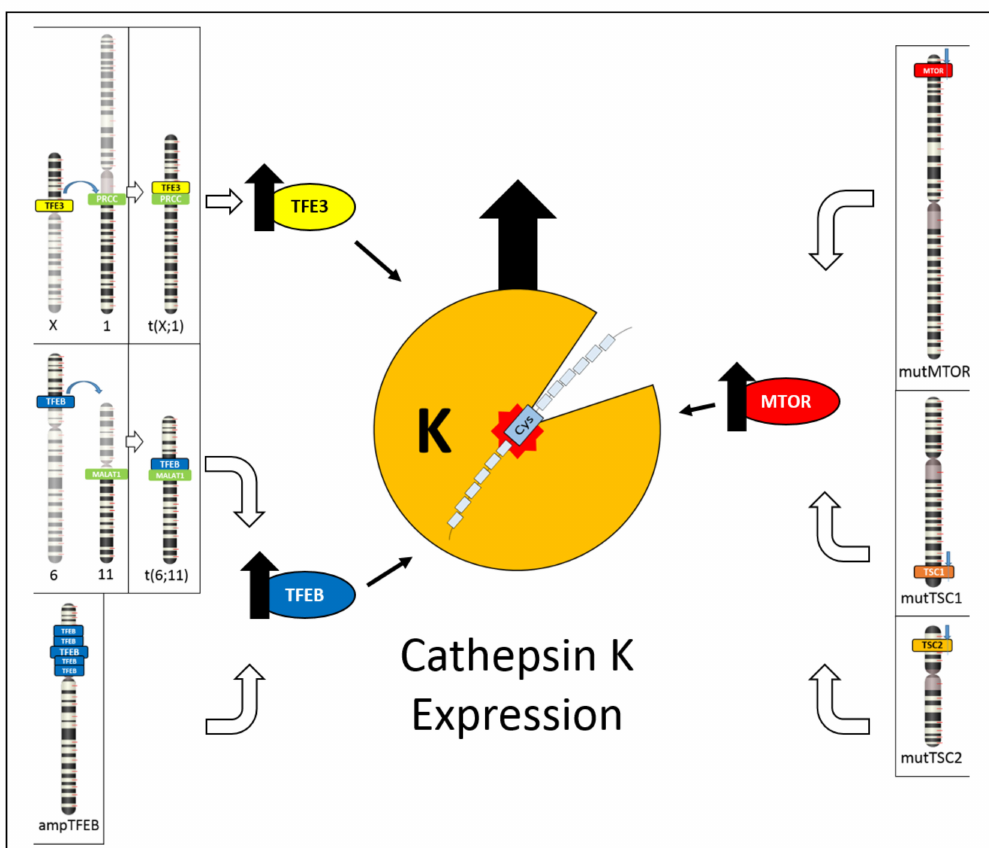
Figure 6. Schematic illustration showing the different mechanisms leading to cathepsin K expression. On the left, TFE3 hyperexpression due to TFE3 gene translocation and TFEB hyperexpression due to either TFEB gene translocation or TFEB gene amplification cause cathepsin K expression. On the right, inactivating mutations of TSC1/TSC2 genes or activating mutations of mTOR gene causes mTOR pathway activation, resulting in cathepsin K